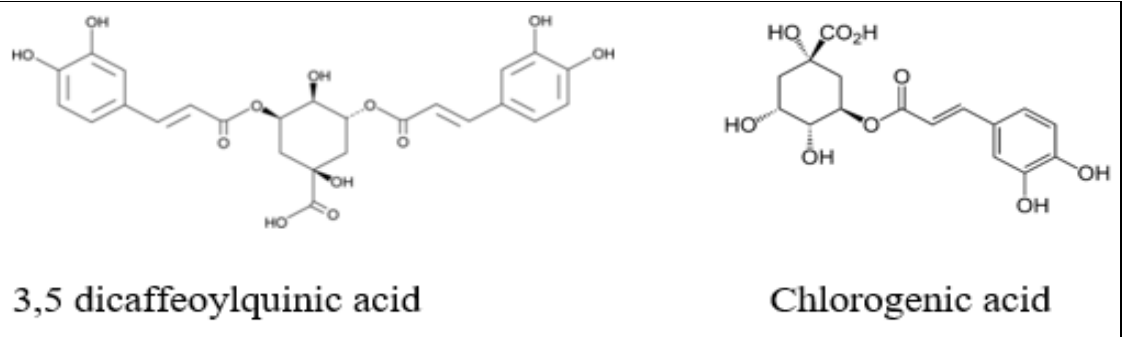
Figure 3. Chemical structures of phenolic acids ( 3,5 dicaffeoylquinic acid and chlorogenic acid) (39, 40)